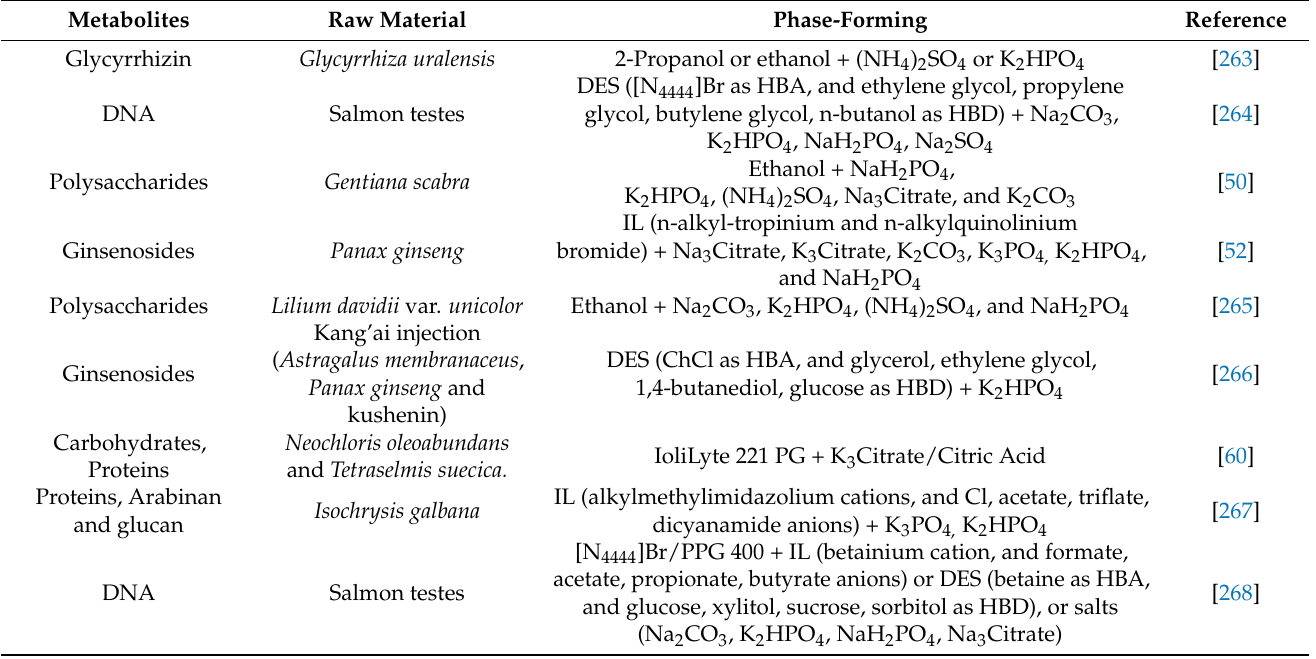
Table 4. Nonconventional ATPS in the extraction and recovery of other plant, marine, and algae